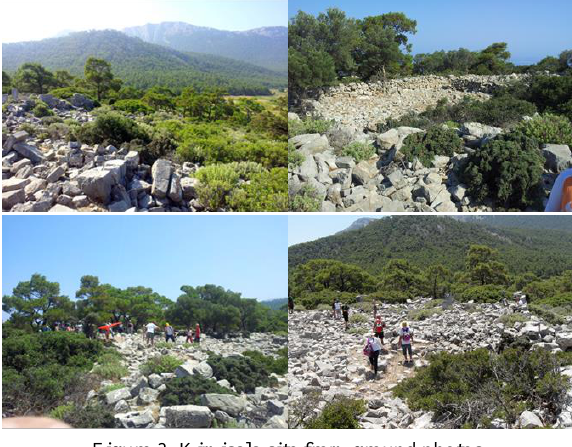
Figure 3: Kimisala site from ground photos